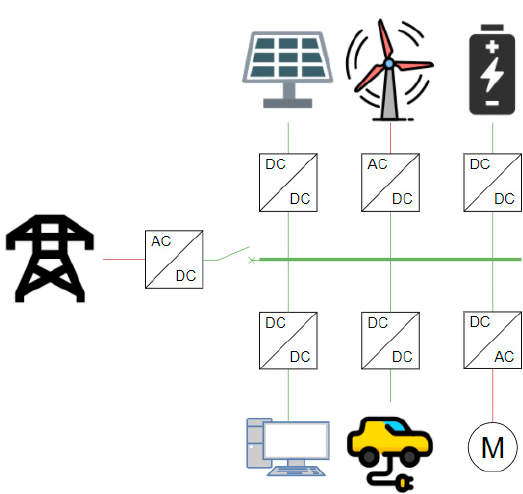
Figure 3 . Single-bus configuration. Figure 3. Single-bus